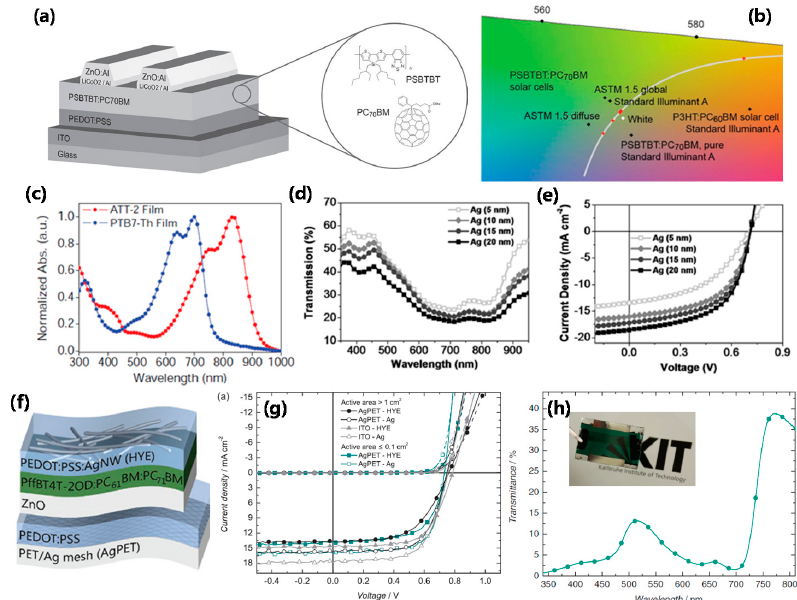
Figure 5. ( a ) Device architecture of STOSCs comprising a PSBTBT:PC 70 BM active layer, a sputtered ZnO:Al transparent cathode, and a LiCoO 2 /Al interfacial layer; ( b ) Determination of the color rendering index. The white dots represent the color coordinates of the TCS01–08 illuminated by the reference Standard Illuminant D. The black needles correspond to the TCS01–08 illuminated from the PSBTBT:PC 70 BM solar cell transmitted light. Reprinted with permission from [45]. Copyright 2011 Wiley. ( c ) Normalized UV-vis-NIR absorption spectra of PTB7-Th and ATT-2 in thin films; ( d ) Transmission spectra of STOSCs as a function of Ag thickness; ( e ) J - V curves of STOSC devices. Reprinted with permission from [48]. Copyright 2011 Wiley; ( f ) Schematic diagram of a typical Ag mesh/PEDOT:PSS/ZnO/PffBT4T-2OD:PC 61 BM:PC 71 BM/PEDOT:PSS:Ag NWs STOSC; ( g ) J - V curves of STOSCs comprising different electrode combinations under AM1.5 illumination (solid lines) and in the dark (dashed lines); ( h ) Transmittance spectrum of STOSCs. Reprinted with permission from